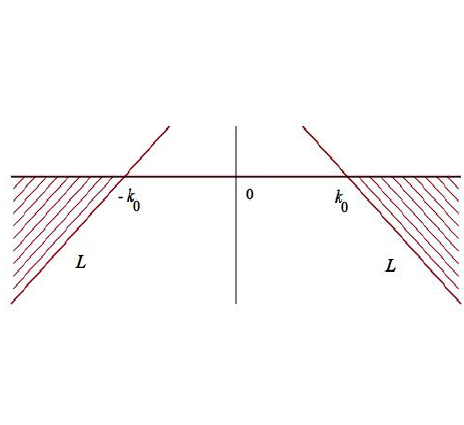
Figure 6. Part of Re i θ ( k ) > 0 in the lower half k